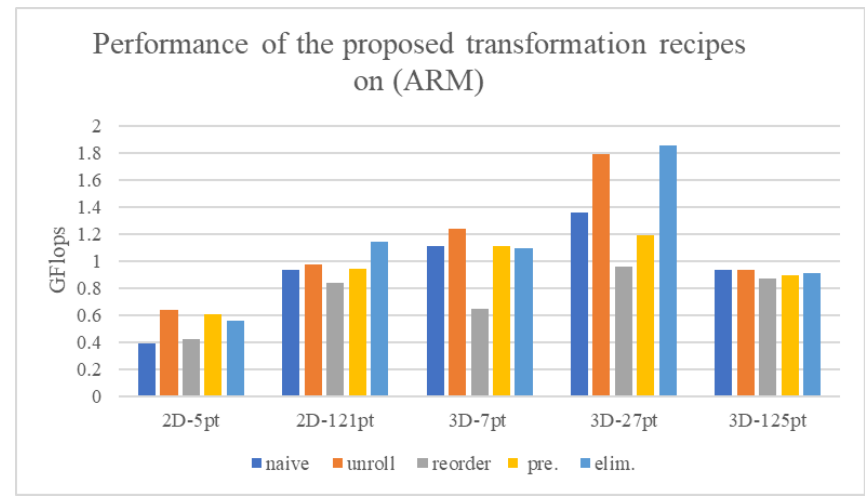
Figure 5. Experimental results of the proposed transformation recipes: (a) single recipe (ARM).